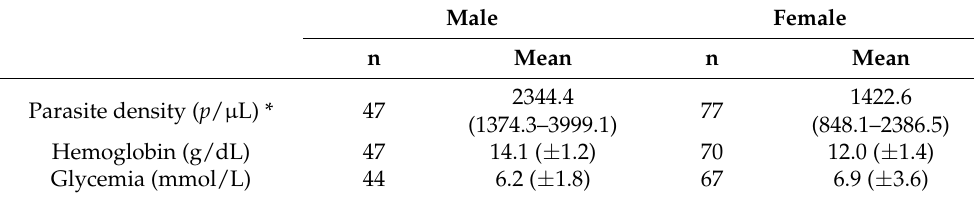
Table 2. Laboratory parameters of malaria patients (cases).